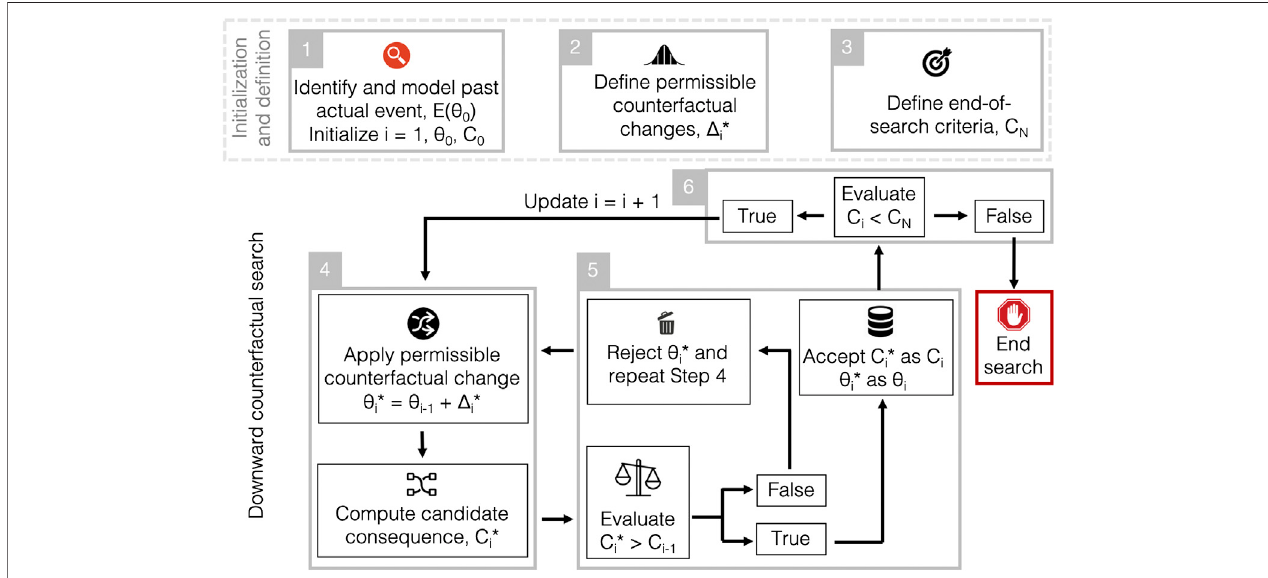
FIGURE 1 | Downward Counterfactual Framework to transform past events into unrealized disasters. The framework begins with a de fi nition of E ( θ 0 ) where θ 0 describes a vector of input parameters corresponding to the original realized event, and the past consequence, C 0 in Step 1. The counter, i , indicates the number of counterfactual events in the chain, with i (cid:2) 0 describing the original event. In Steps 2 and 3, permissible changes and an end-of-search criteria are de fi ned, respectively. Changes to θ i − 1 are then applied and assessed in the downward counterfactual search (Steps 4 – 6). Candidate values that are to be assessed for acceptance or rejection are indicated by an asterisk (*).